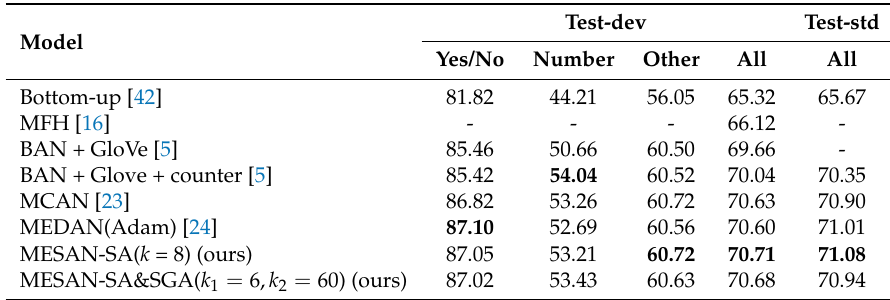
Table 3. Results of the state-of-the-art single models and our models on VQA v2. All the models use the same bottom-up attention visual features and are trained, validated, and tested on VQA v2. The best results on both splits are bold.